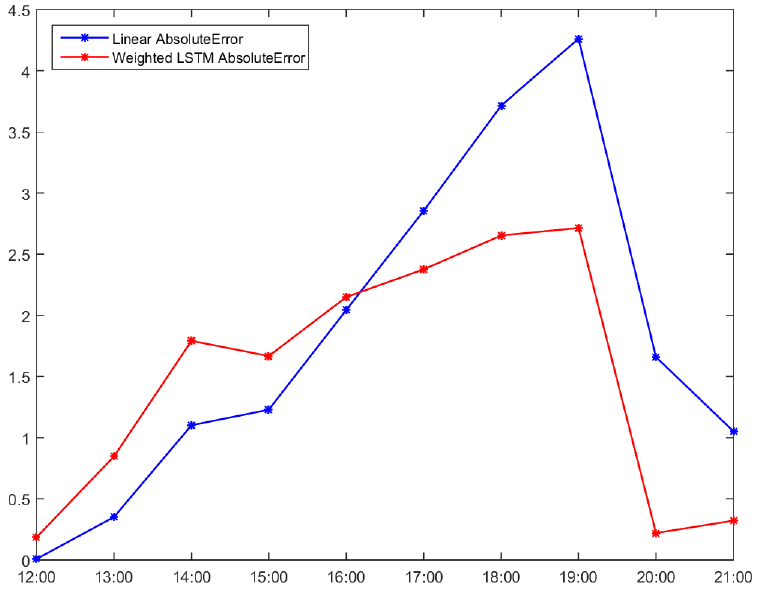
Figure 16. Comparison of errors between the LSTM estimate and weight-applied compensation method and the linear interpolation